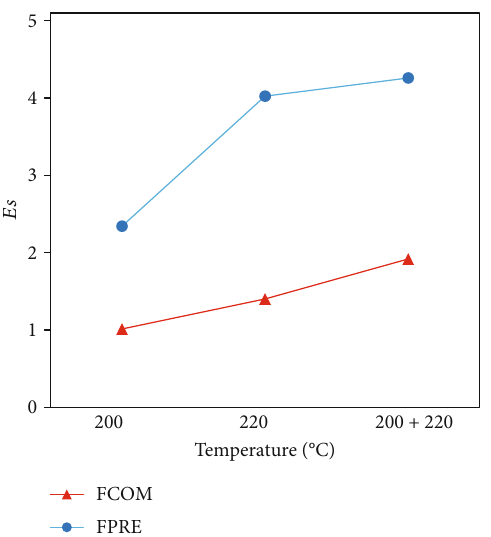
Figure 8: Extent of stabilization ( Es ) of FPRE and FCOM heated at di ff erent temperatures.